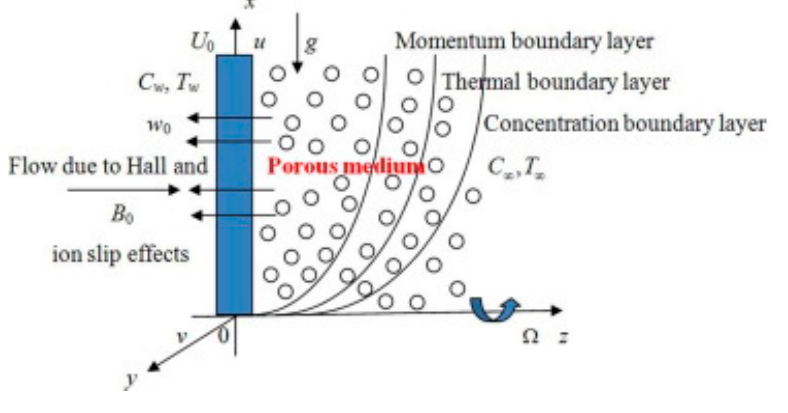
Figure 1. Flow diagram.